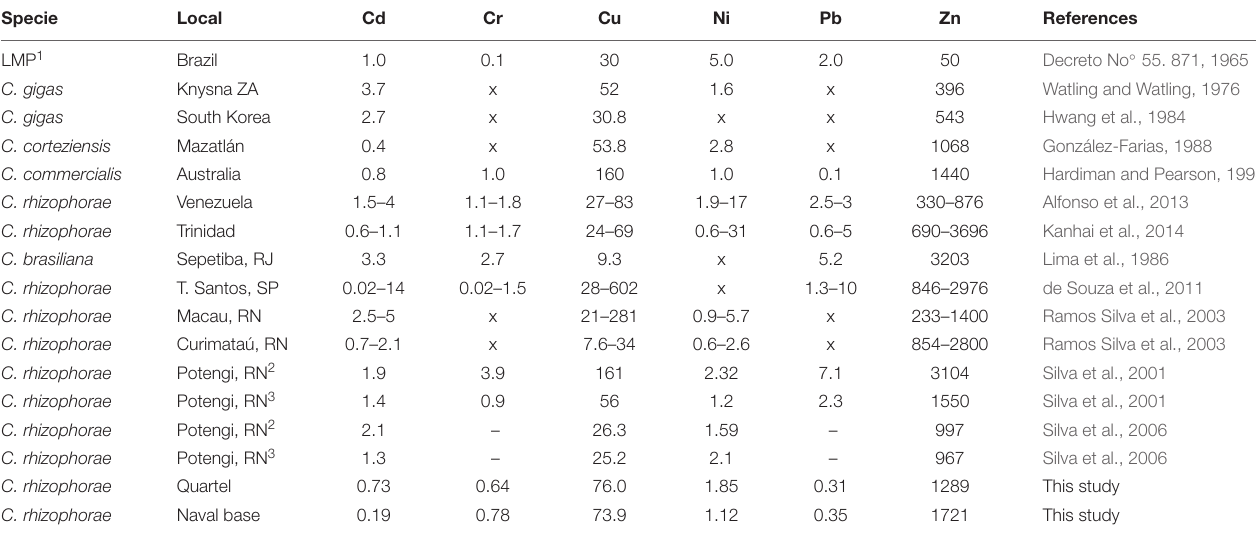
TABLE 2 | Metals concentrations in Crassostrea sp.: Means and ranges obtained in the literature and this study. Specie